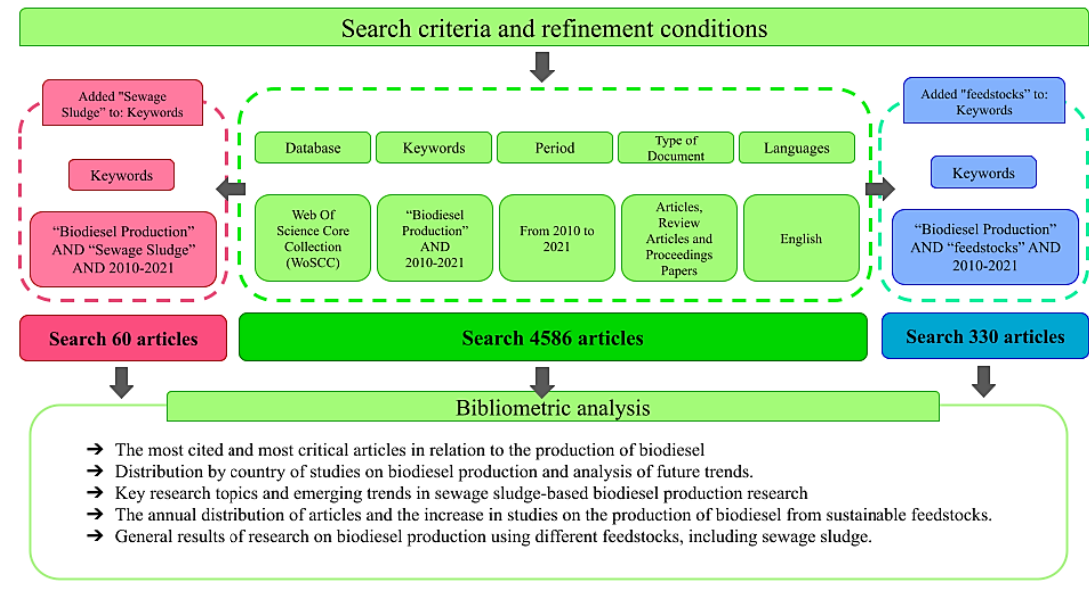
Figure 2. Search and analysis criteria used for the data collection stage.